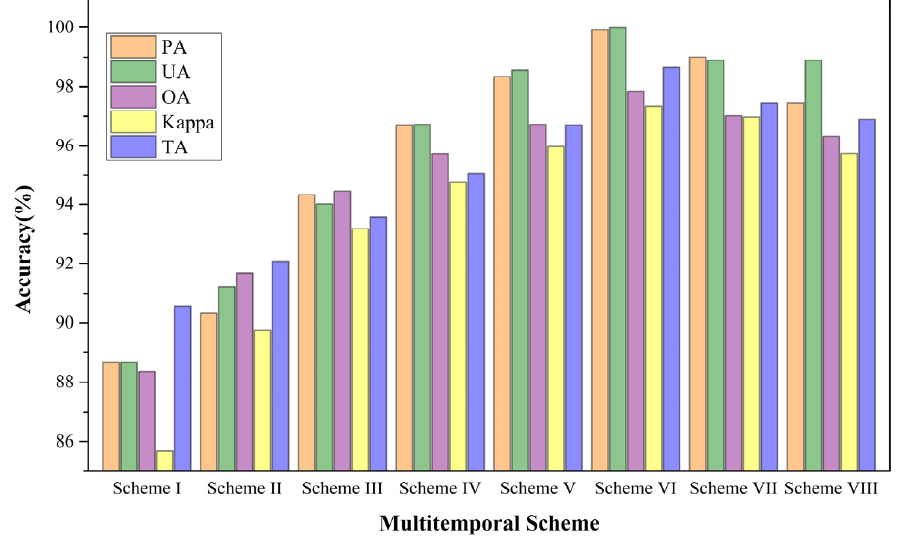
Figure 7. Results of accuracy indicators for each multi-temporal scheme.